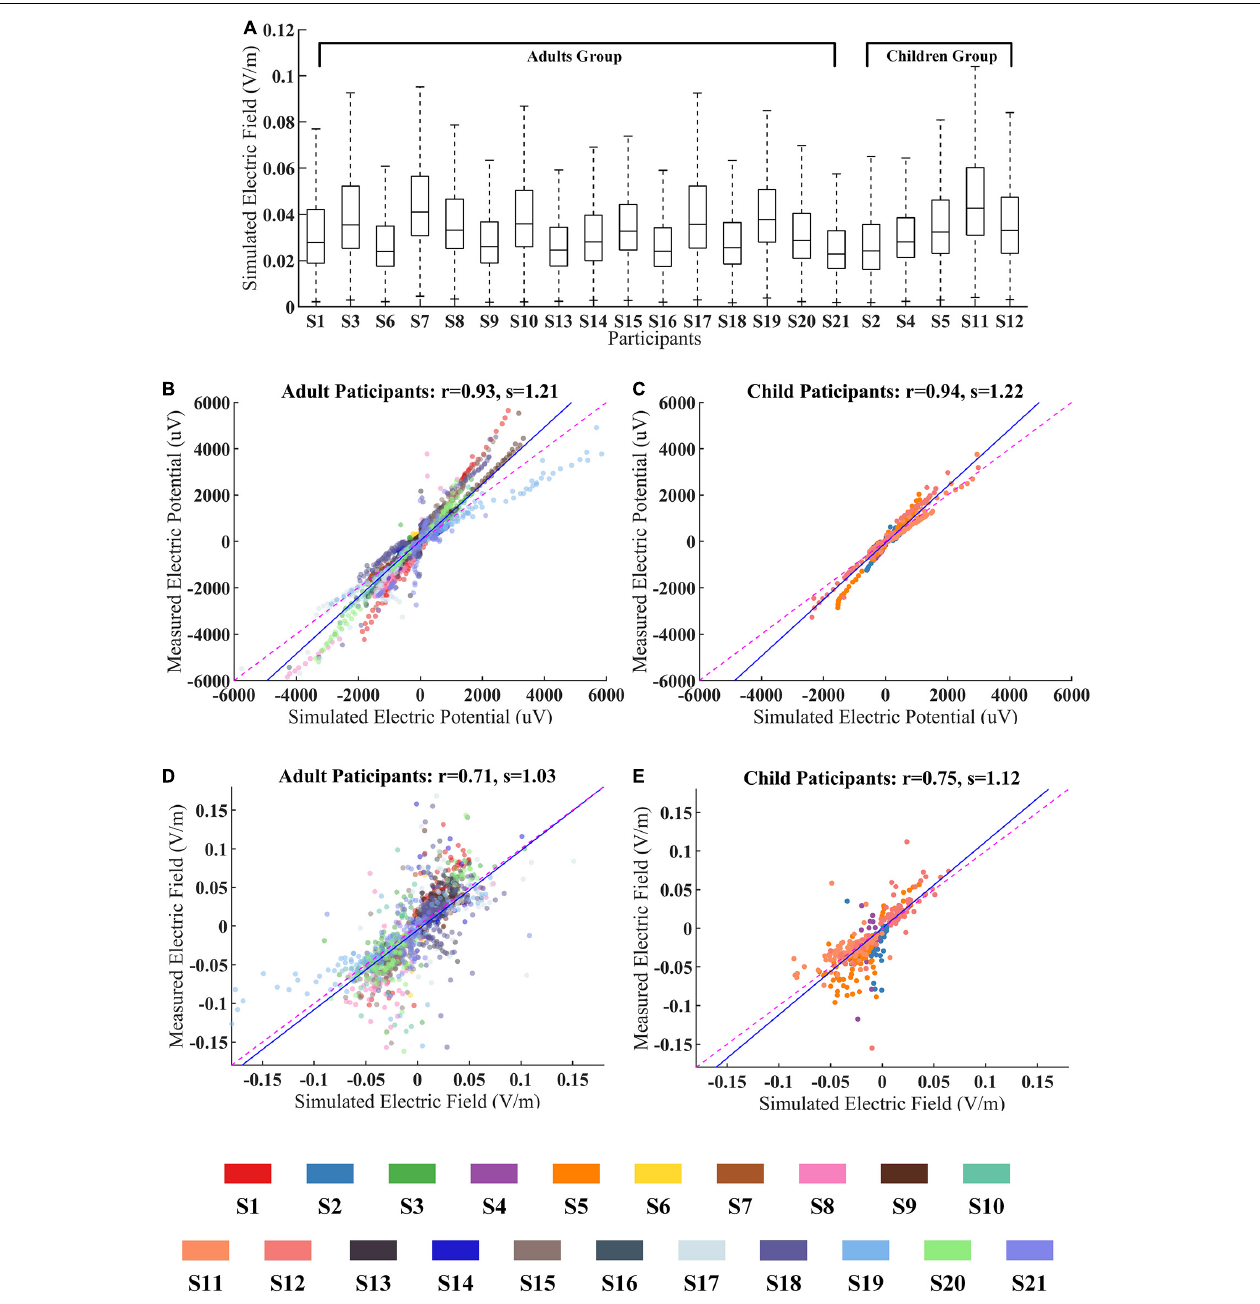
FIGURE 6 | The age effect between adults and children during CES. (A) Simulated electric fields (EFs) for all participants within WM and GM. (B,C) The measured voltages and predicted ones for adults and children groups. (D,E) The measured EFs and predicted ones for adults and children groups. The data from different participant were represented by the color-coding of participants at the bottom of the figure.